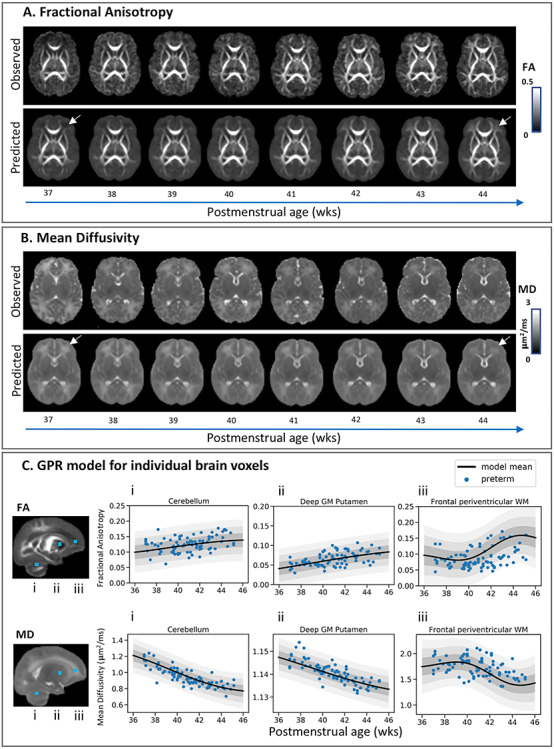
Modelling the developing brain microstructure using Gaussian process regression. Observed and predicted individual infant fractional anisotropy (A) and mean diffusivity (B) maps for eight full-term infants randomly selected to represent every week between 37 and 44 weeks PMA. The effect of PMA is best seen in the frontal periventricular WM, highlighted by the white arrows. The predicted developmental trajectories are plotted for three randomly selected brain voxels (C) located in the cerebellum (i), deep GM putamen (ii), and frontal periventricular WM (iii). The relative location of the voxels is highlighted with blue squares on the observed mean FA and MD maps. Plots show the model mean (thick black) ±1 (dark gray), ±2 (light gray), and ±3 (lighter gray) standard deviations from the predicted mean and the diffusion values extracted for these voxels for all 82 preterm infants.